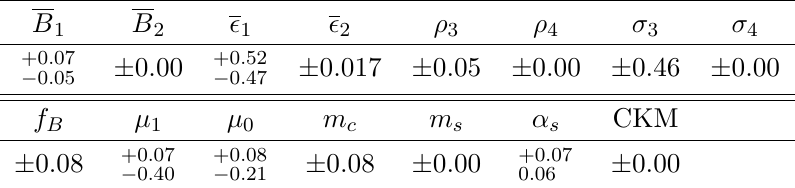
Table 9 . Individual errors for the ratio (cid:28) ( D + ) =(cid:28) ( D 0 ) in the PS mass